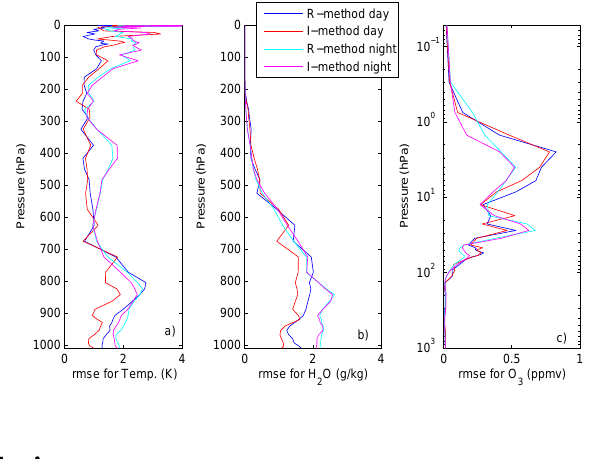
Figure 15. Results for the tropical case study for ( N = 300 , x shows the retrieval performance expressed in terms of root mean square error (rmse) for (a) temperature, (b) water vapour and (c)